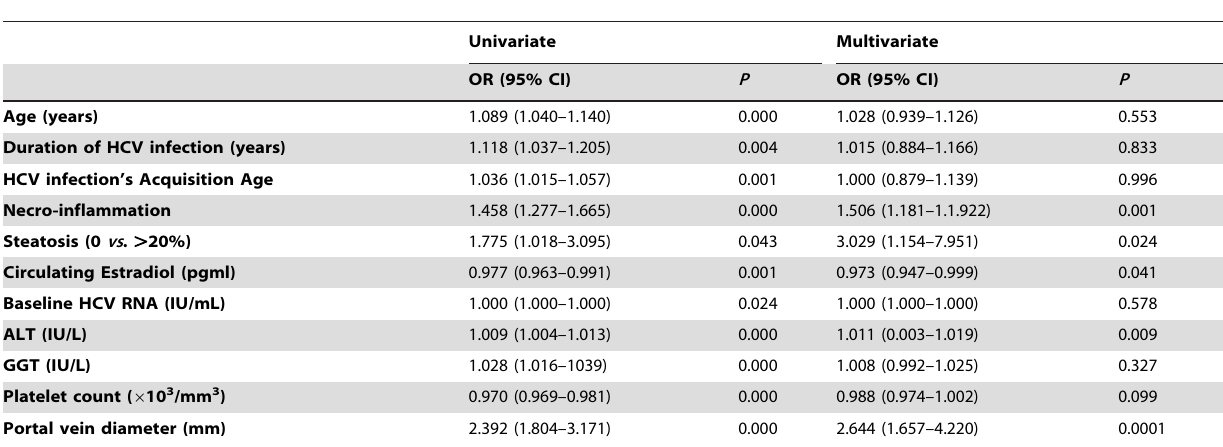
Table 1. Univariate and multivariate analysis for fibrosis in the women with chronic hepatitis C.